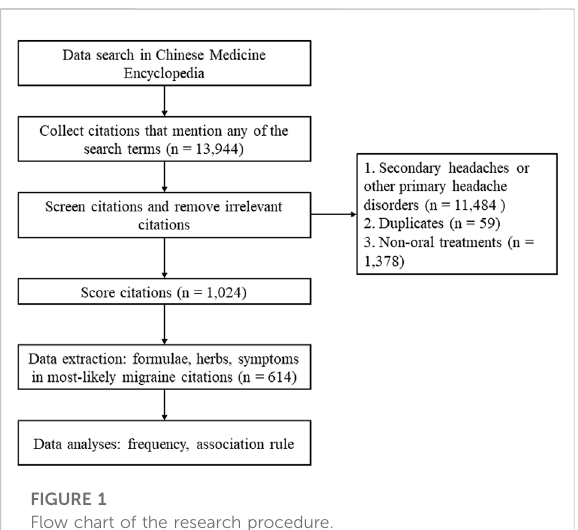
FIGURE 1 Flow chart of the research